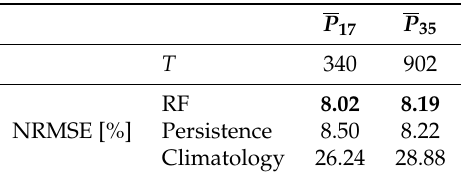
for five-minute ahead forecasts of average aggregated power. Results are shown for the remote sensing-based forecasting (RF) model, persistence and climatology